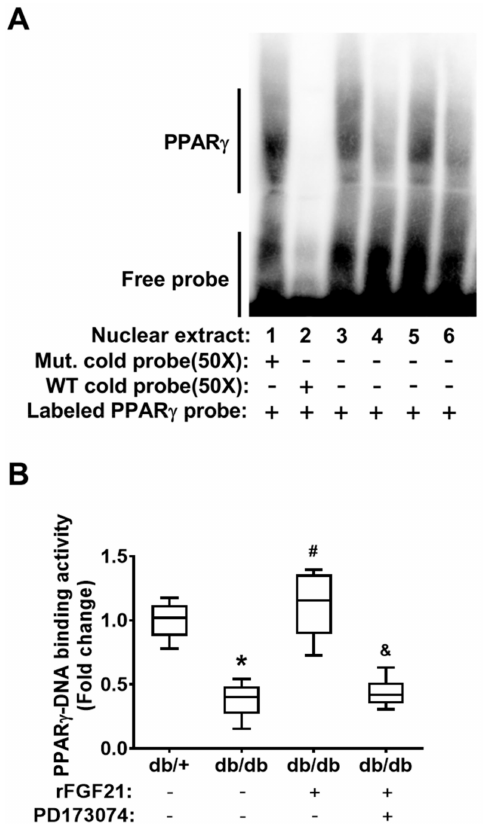
Figure 1. Recombinant fibroblast growth factor 21 (rFGF21) increases peroxisome proliferator-activated receptor gamma (PPAR γ ) DNA-binding activity via FGFR1 at a peri-infarct area after distal middle cerebral occlusion (dMCAO) in db / db mice. At 24 h poststroke, the transcriptional factor PPAR γ DNA-binding activity in nuclear fractions was measured by an electrophoresis mobility shift assay (EMSA). ( A ) Representative image of the EMSA gel. The order of sample loading: lanes 1–3 were for all db /+ stroke, lane 4 was for db / db stroke, lane 5 was for db / db stroke + rFGF21, and lane 6 was for db / db stroke + rFGF21 + PD173074. ( B ) Densitometric quantification of specific PPAR γ DNA-binding bands. Data are illustrated as box-plots with the median, lower and upper quartiles, minimal and maximal value ( n = 6 per group). * p < 0.05 for db / db stroke vs. db /+ stroke; # p < 0.05 for db / db stroke + rFGF21 vs. db / db stroke; & p < 0.05 for db / db stroke + rFGF21 + PD173074 vs. db / db stroke + rFGF21. 2.2. rFGF21 Reduces BBB Extravasation via PPAR γ Activation at a Peri-Infarct Area after dMCAO in db / db Mice E ff ects of rFGF21 on poststroke BBB leakage were tested by a BBB extravasation assay using two di ff erent tracers: TMR-dextran (3 kDa) and Evans blue dye (approximately 68 kDa after binding with albumin in the circulation) (Figure 2A). At 48 h after dMCAO, as we expected, the extravasation assay showed a dramatic increase in BBB leakage in db / db mice compared to in db /+ mice as controls (117.6% increase of 3 kDa TMR-dextran and 167% increase of Evans blue dye) (Figure 2B,C). Importantly, rFGF21 administered at 6 h after stroke onset significantly lowered the leakage of both tracers in db / db mice (52% reduction in 3kDa TMR-dextran leakage and 43.2% reduction in Evans blue dye leakage). However, the treatment at 30 min prior to rFGF21 administration with GW9662 eliminated the inhibitory e ff ect of rFGF21 on BBB extravasation (Figure 2B,C). These results suggested that the potentiated BBB leakage after ischemic focal stroke in T2DM can be largely (about 50%) protected by rFGF21 and this beneficial e ff ect might be contributed by PPAR γ